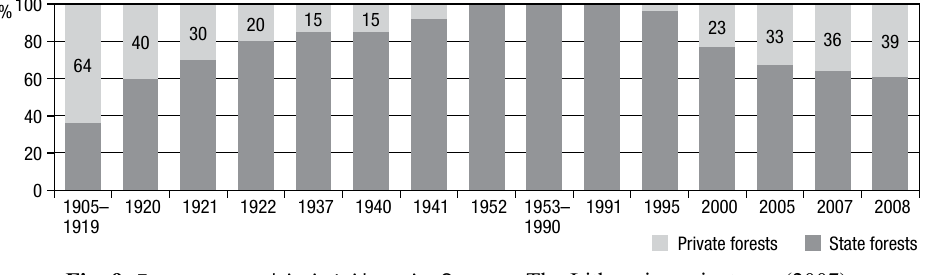
Fig. 9. Forest ownership in Lithuania. Sources : The Lithuanian private …